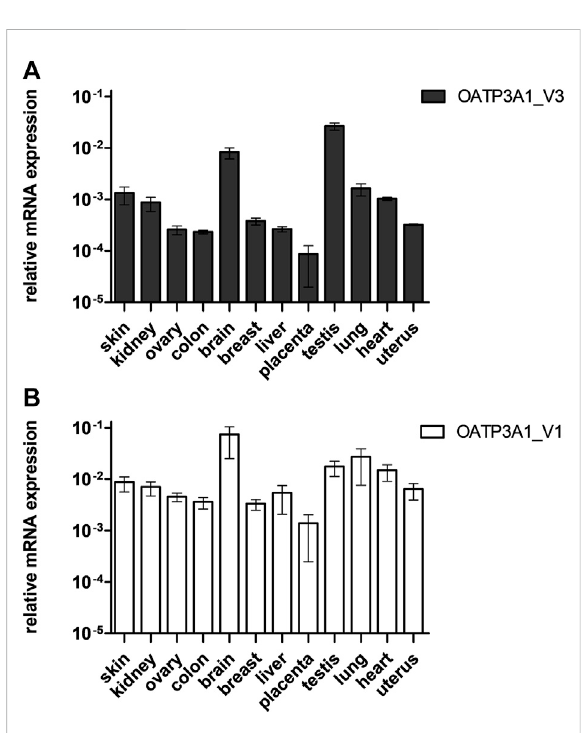
FIGURE 2 Relative mRNA expression of OATP3A1_V3 in human